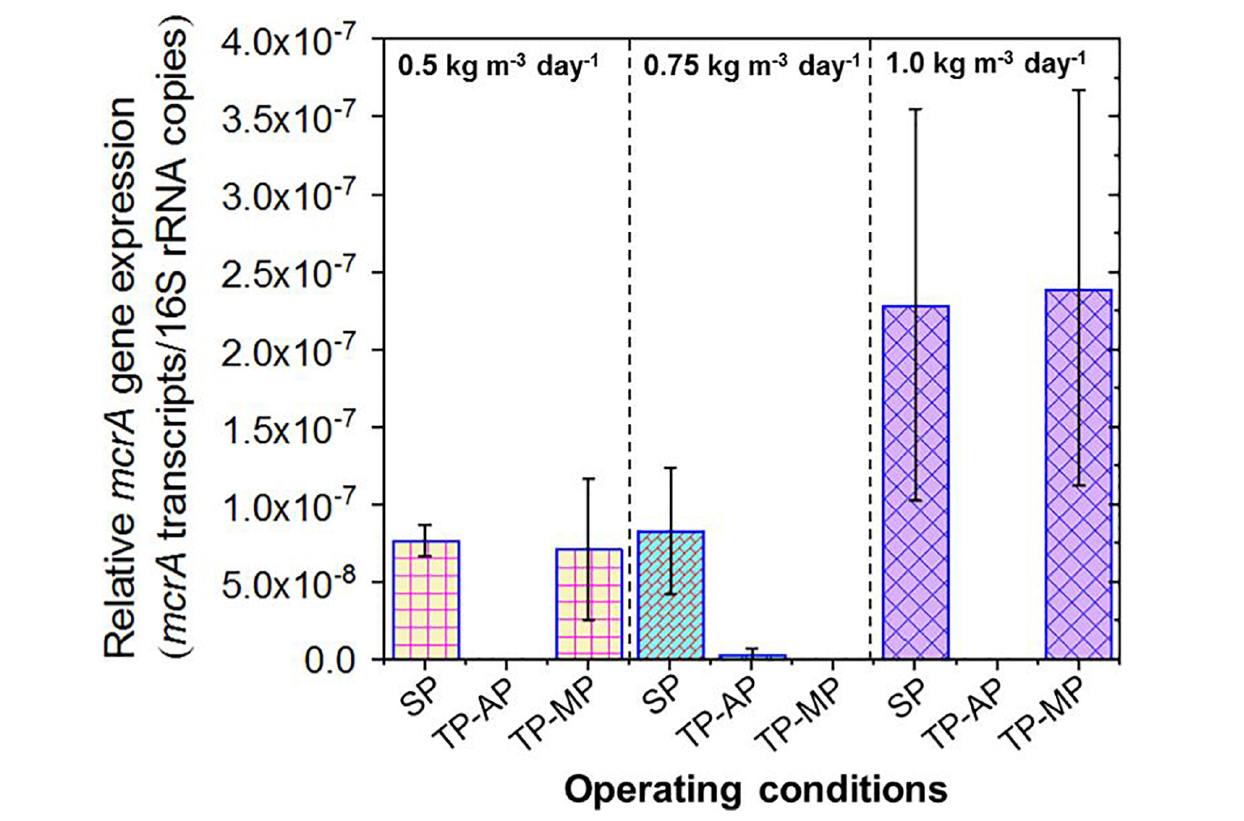
FIGURE 5 | Relative expression of mcrA genes in the samples from all operating conditions. Copies of mcrA transcripts were normalized to total 16S rRNA copies. Due to the accidental loss of extracted RNA from TP-MP-0.75 samples, no corresponding data is presented here.